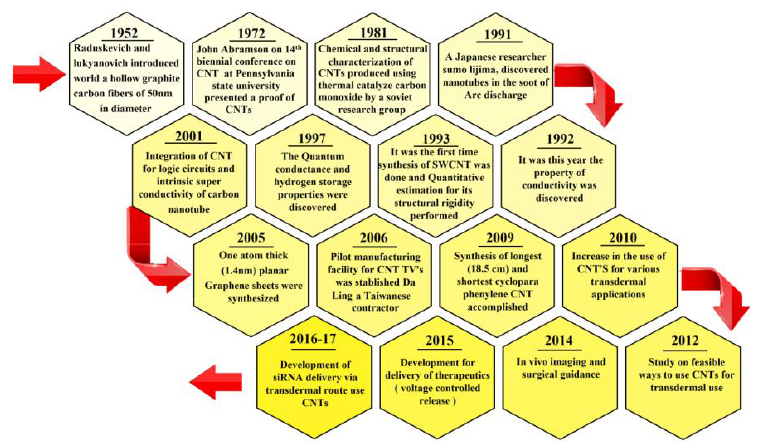
Figure 2. Schematic illustration of the morphological structure of CNT.